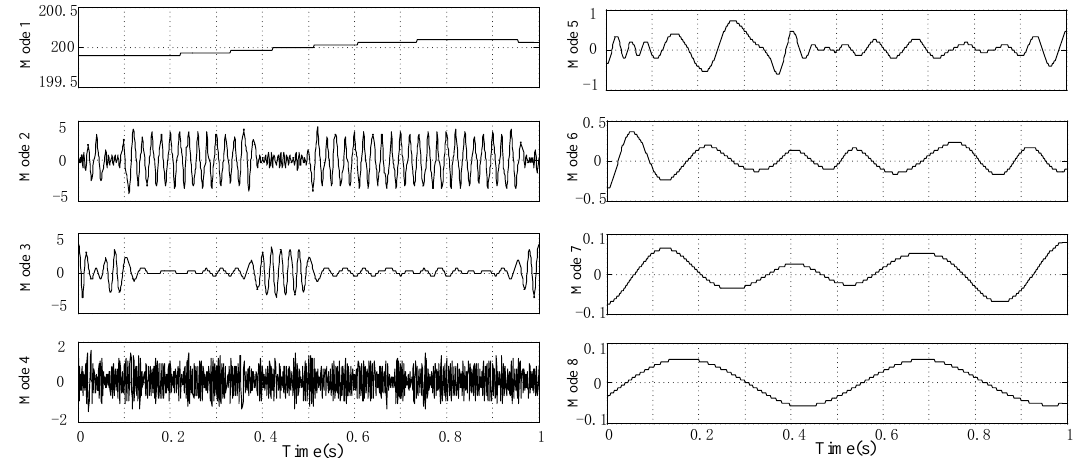
Figure 17. The decomposed modes of EMD algorithm.